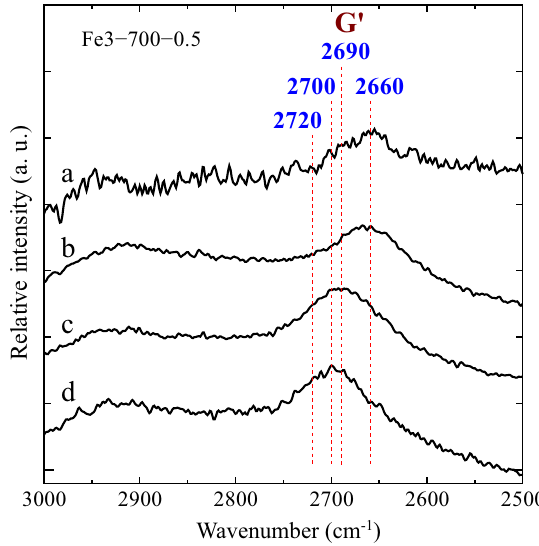
Fig. 5 Measurement-point dependence of Raman shifts and spectral line-shapes of G ʹ -bands observed from Fe3-700-0.5: a , b , c , d ,